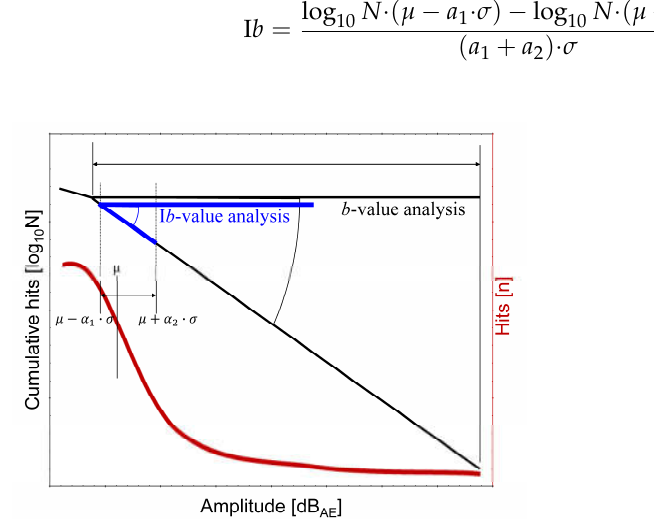
Figure 4. b - and I b -value analysis [28].